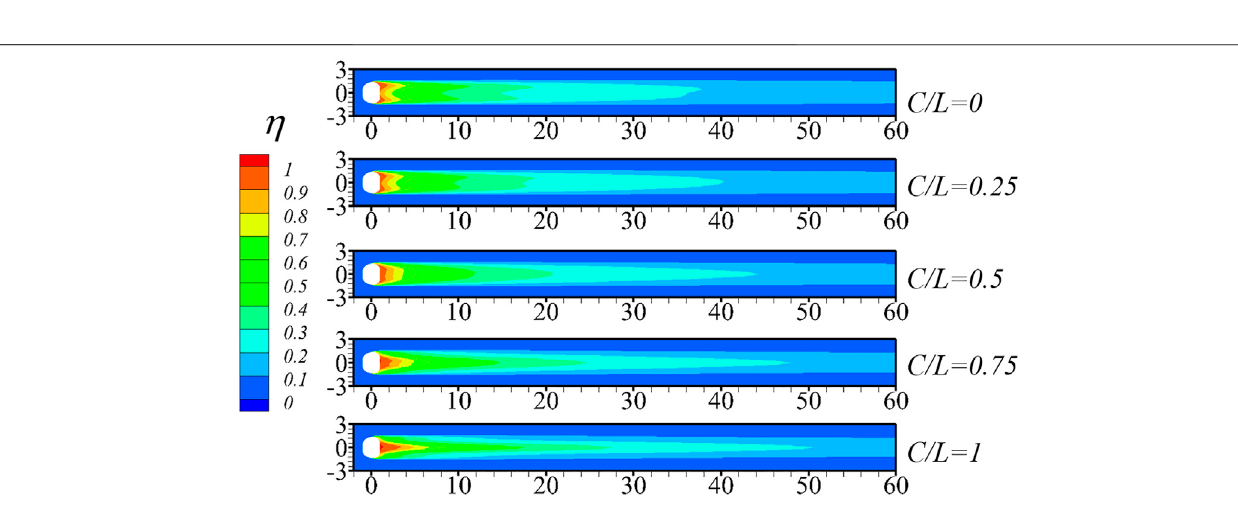
Frontiers in Energy Research |